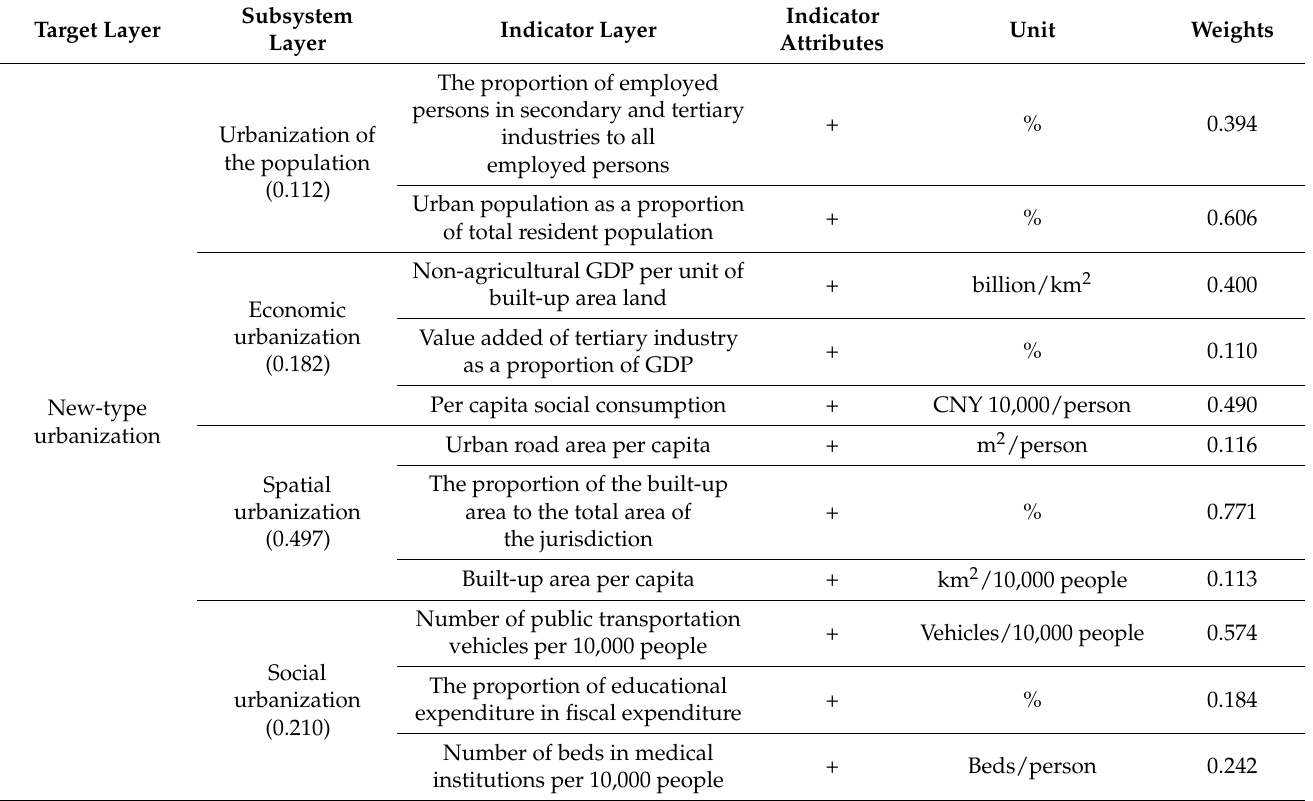
Table 2. Evaluation index system of the